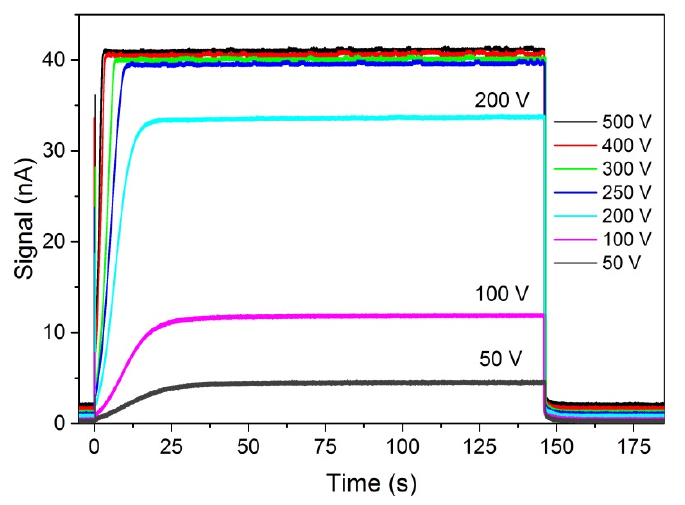
Figure 12. PC kinetics after rapid (~0.5 ms) turning on the illuminating light, F = 1.55 × 10 12 cm − 2 s − 1 , ħω = 1.608 eV ( E g + 33 meV), at different voltages. Charge carriers are generated at the surface of the sample. The PC time dependence does not change much above 250 V.